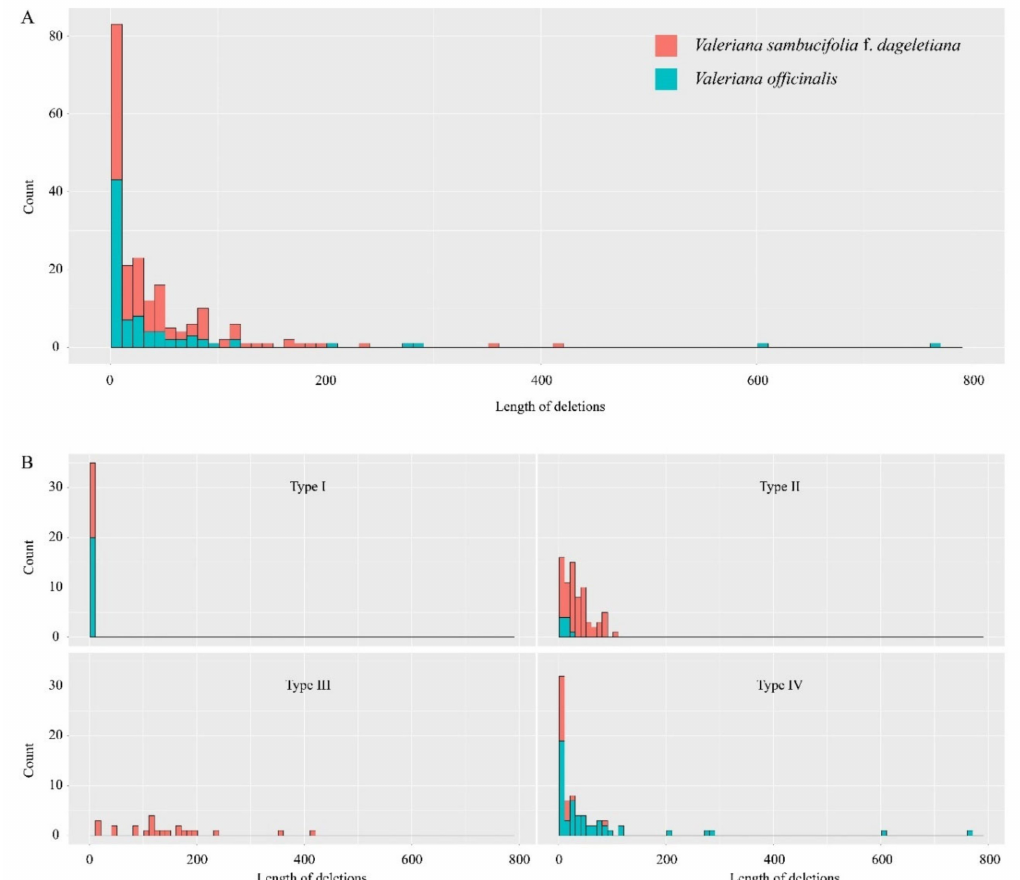
Figure 3. Deletions detected in the plastomes of Valeriana sambucifolia f. dageletiana (red bars) and Valeriana officinalis (green bars). ( A ) Total deletions. ( B ) The different types of